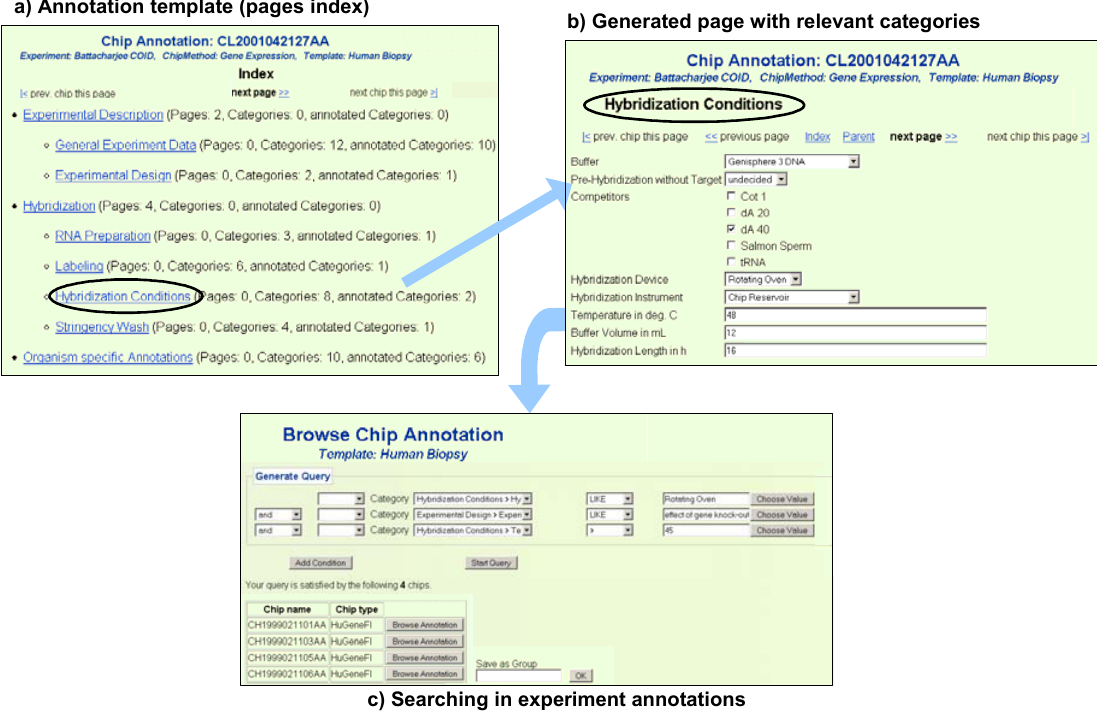
Figure 4: Capturing experiment